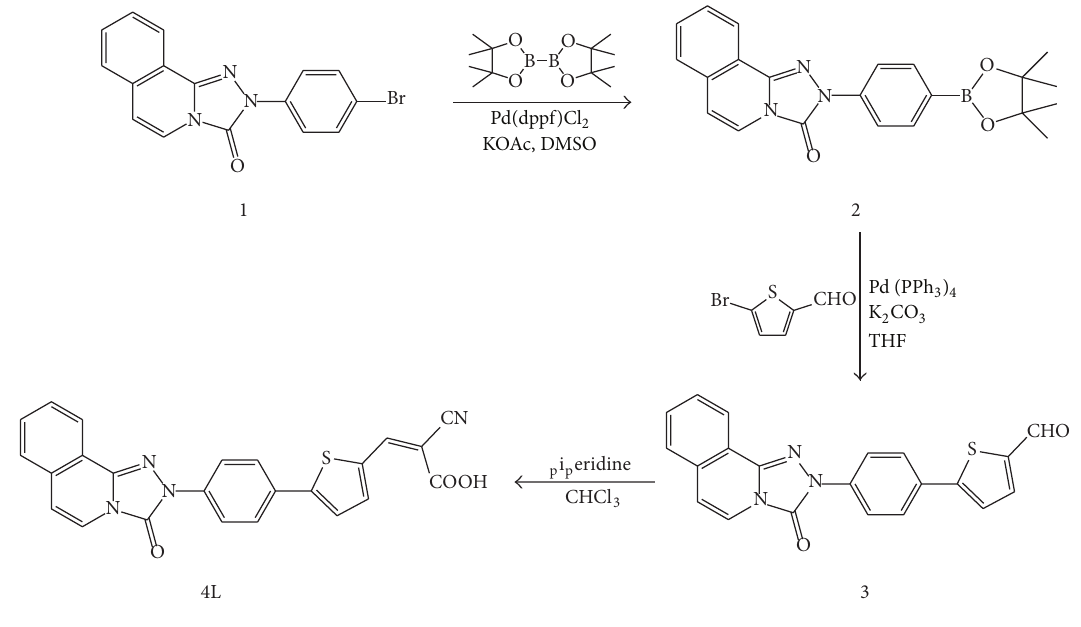
Figure 1: Synthetic route of co-adsorbent 4L.